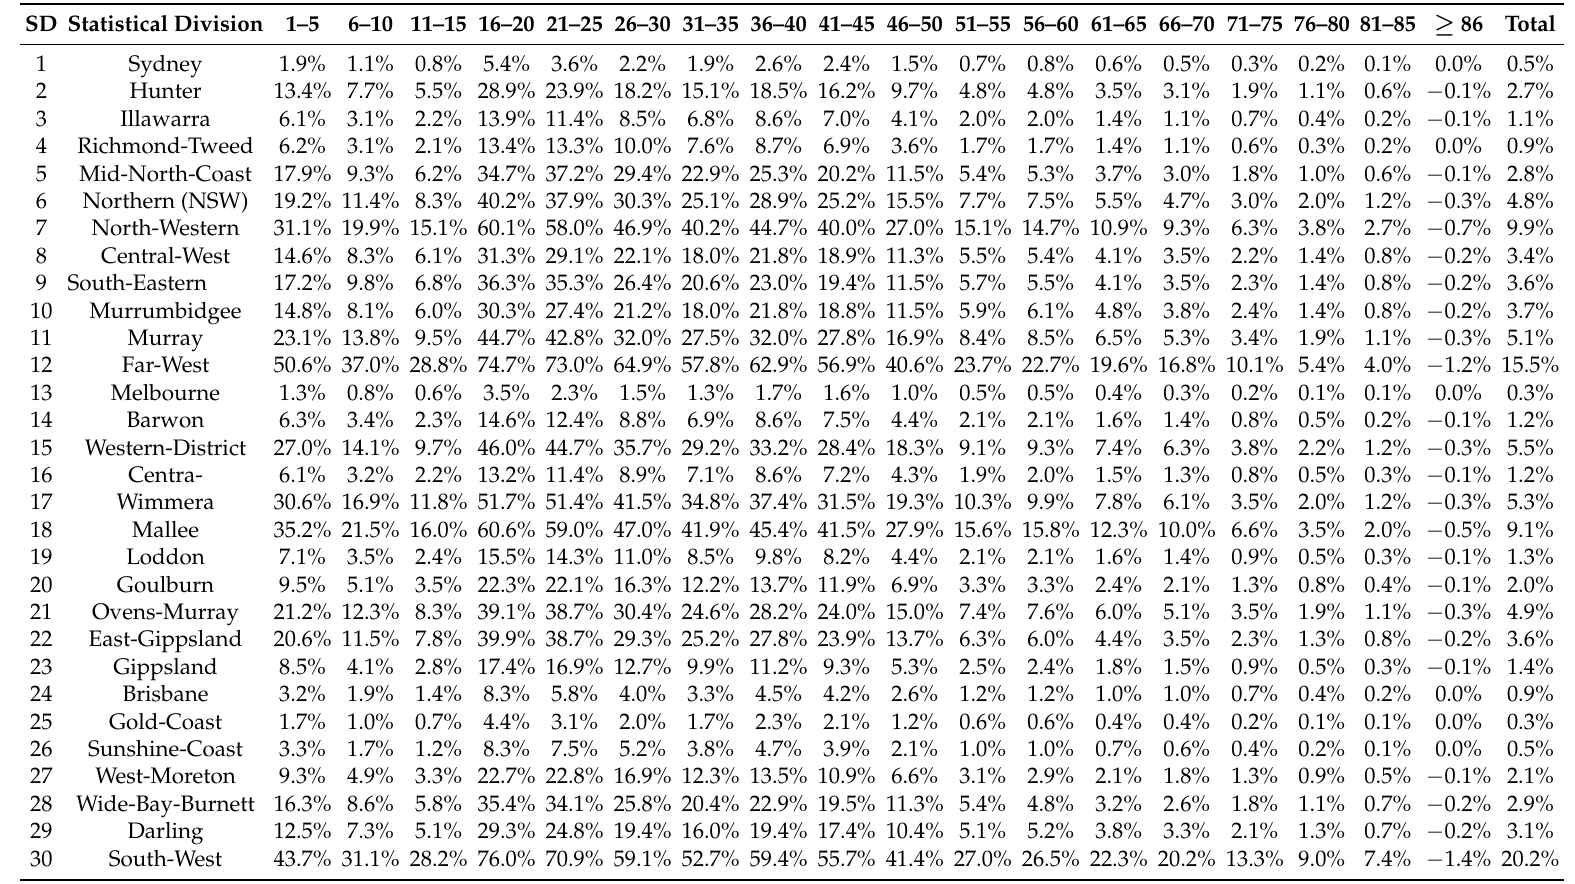
Table A1. Proximity